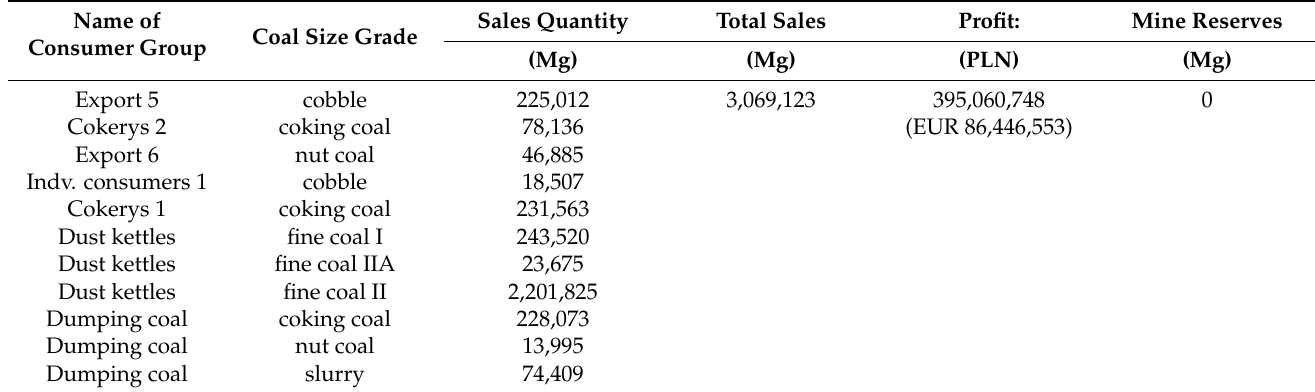
Table 10. The optimal production and sales plan for mine “F” for